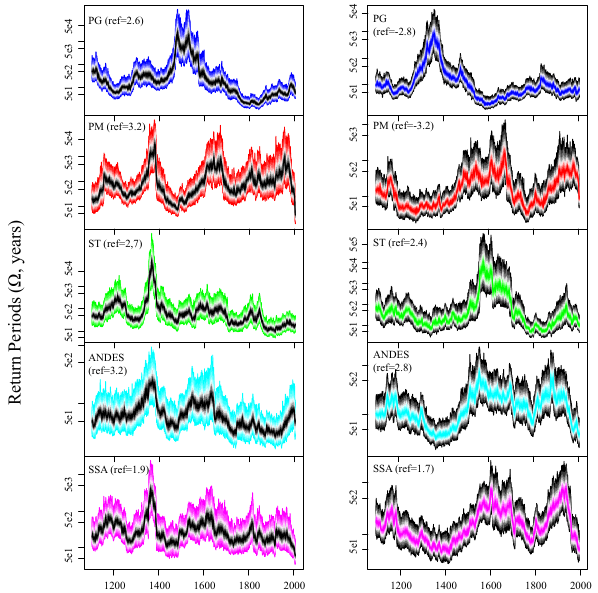
Figure 13 . Past return periods (Ω) (and their 95% bootstrap confidence interval) of events equivalent in magnitude to the reference 50-yr wet spell (left panel) or drought (right panel). The reference 50-yr event (value indicated in parenthesis for each region) was calculated for the 1930-1993 period. All return periods were obtained after fitting a log-normal distribution to the 100 years preceding year t . Color codes for each region are the same as in Figure 3. Return period values on the y axis are exponential values ie. 5e k years =5*10 k years. Thus k values of 1,2 and 3 respectively yield 50-yr, 500-yr and 5000-yr return periods. Confidence intervals are incremented at each 5%, with reversed color directions for wet spells and droughts.